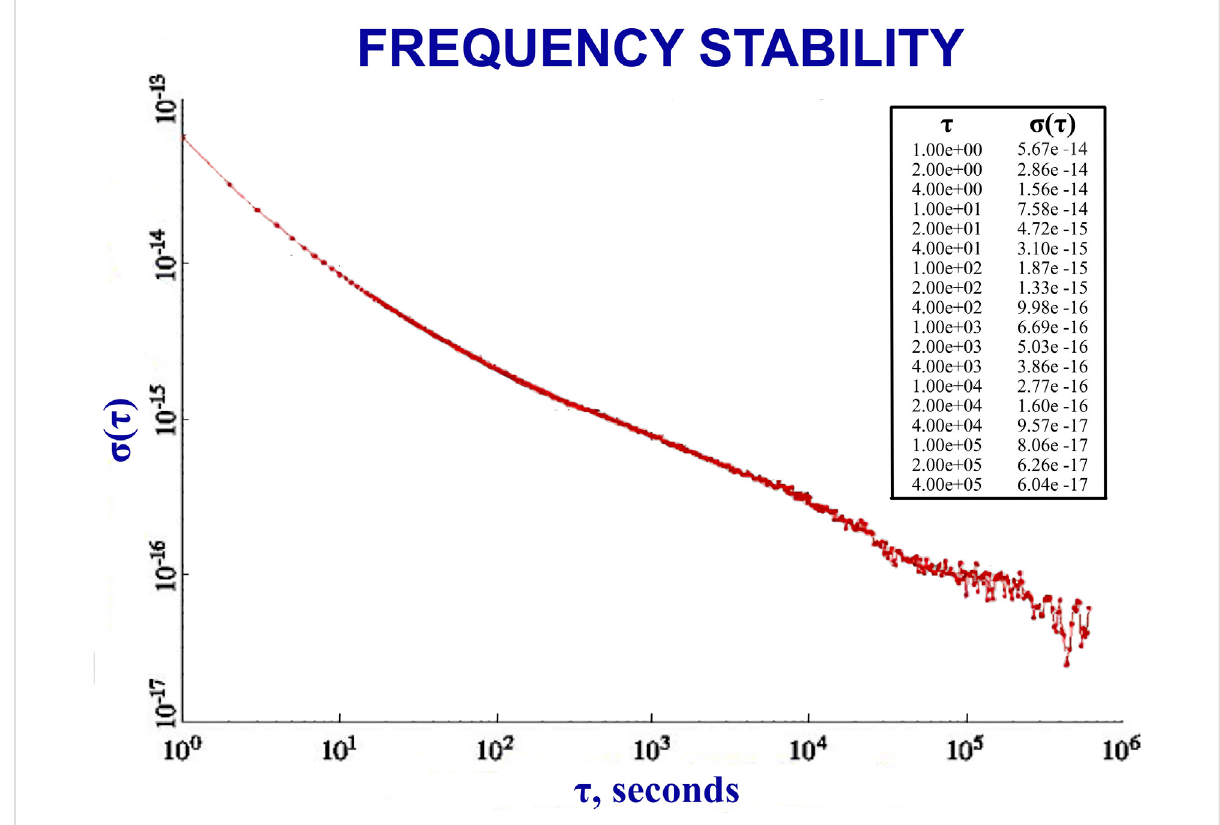
FIGURE 1 Stability performance of a single-state selection system-designed